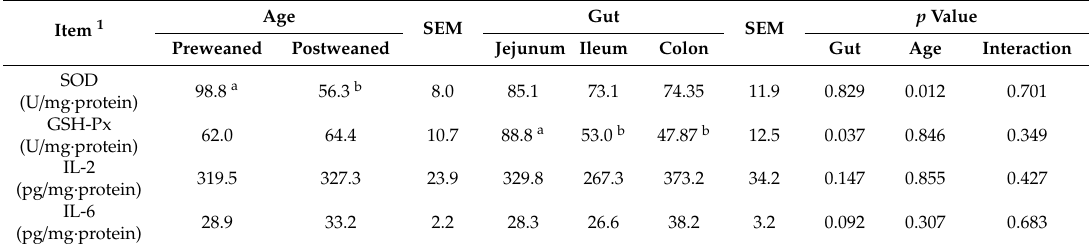
Table 1. Weaning e ff ects on the activities (U / mg · protein) of SOD and GSH-Px, and the concentration (pg / mg · protein) of IL-2 and IL-6 in the colon, ileum, and jejunum of young goats.